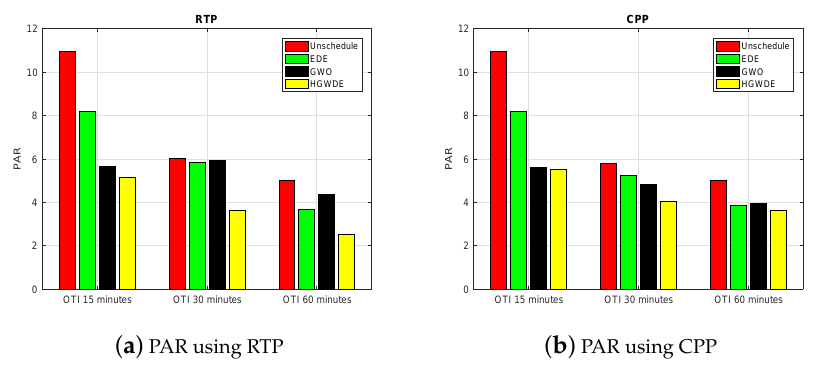
Figure 8. PAR for different OTI’s using RTP and CPP.